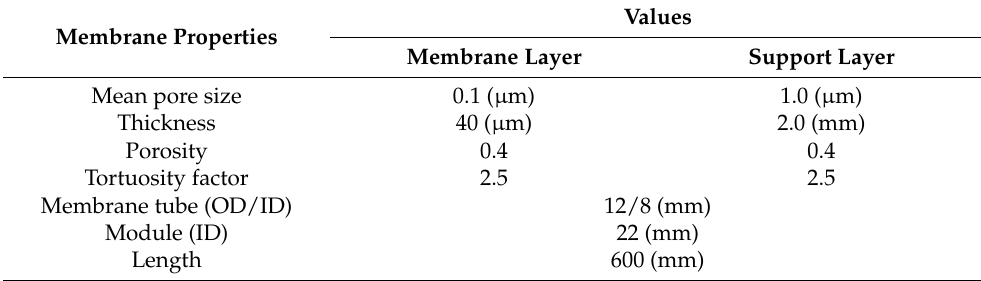
Table 1. Characteristics of the membrane